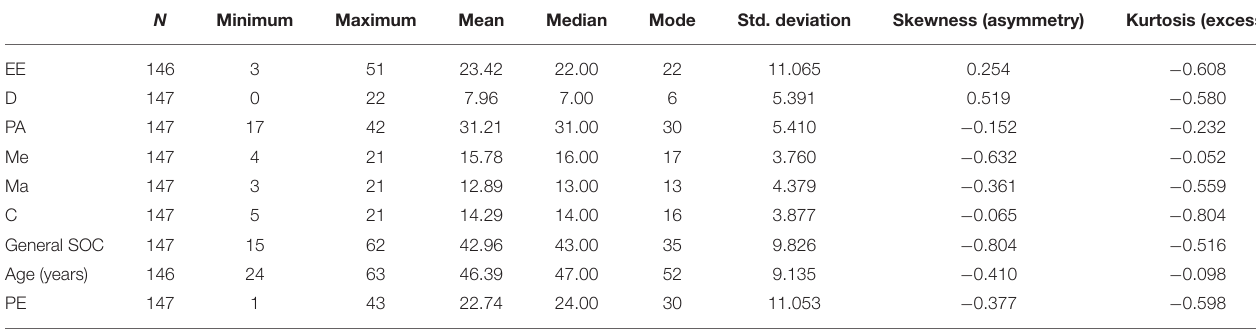
TABLE 1 | Descriptive statistics of the distributions with data for SOC and MBI subscales and other variables in the analyses. N Minimum Maximum Mean Median Mode Std. deviation Skewness (asymmetry) Kurtosis (excess)